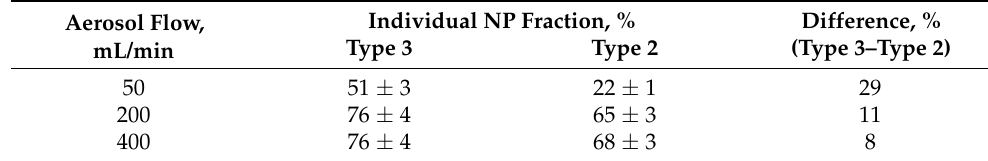
Table 1. Individual NPs fractions for SERS arrays of second and third types.